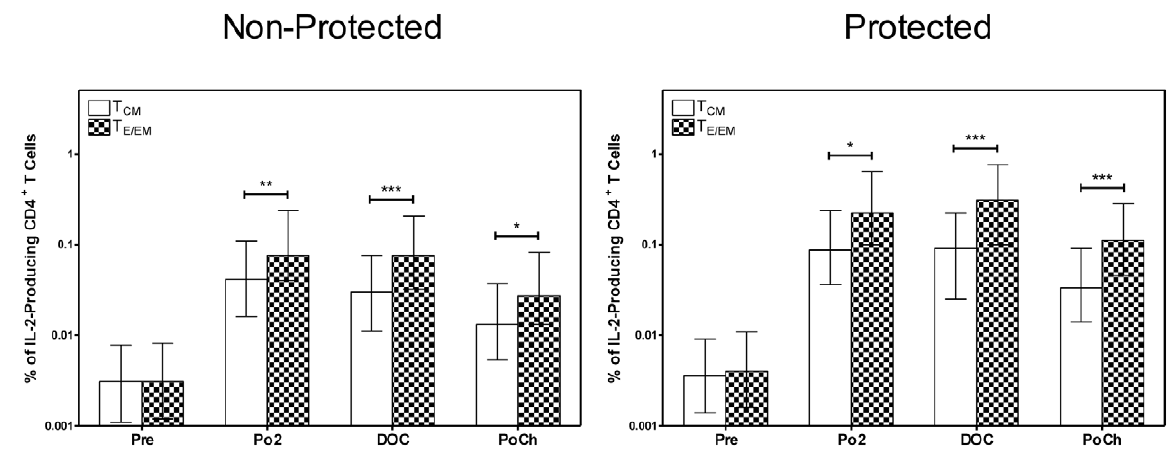
Figure 3. Frequency of CD4 + T CM and CD4 + T E/EM cells producing IL-2 upon recall with CSP peptides. PBMC obtained at the indicated time points from RTS,S-immunized subjects were incubated as described for Fig. 2 with CSP peptides as described in Methods. Cells were then analyzed as described in the legend to Fig. 1. The values are plotted as the frequency of IL-2-producing CD4 + T CM cells (open bars) and IL-2-producing CD4 + T E/EM cells (closed bars) for protected (right-hand panels) and non-protected (left-hand panels) subjects. Error bars indicate 95% confidence intervals. *p , 0.05; **p , 0.01; ***p , 0.001. doi:10.1371/journal.pone.0020775.g003 frequencies of IFN- c + CD4 + T E/EM cells from protected vs. non- protected volunteers.